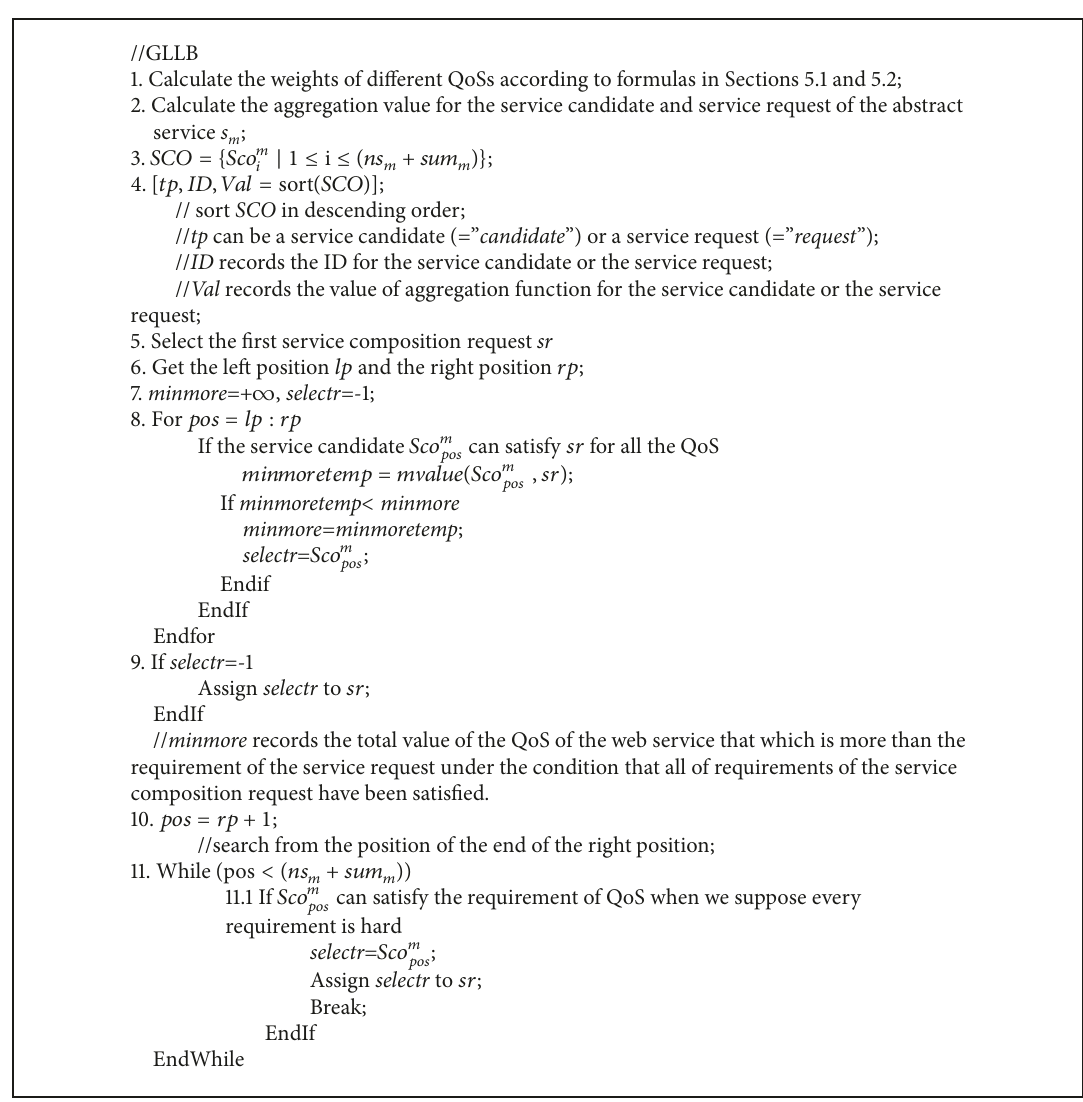
Algorithm 2: Schhard (abstract service s